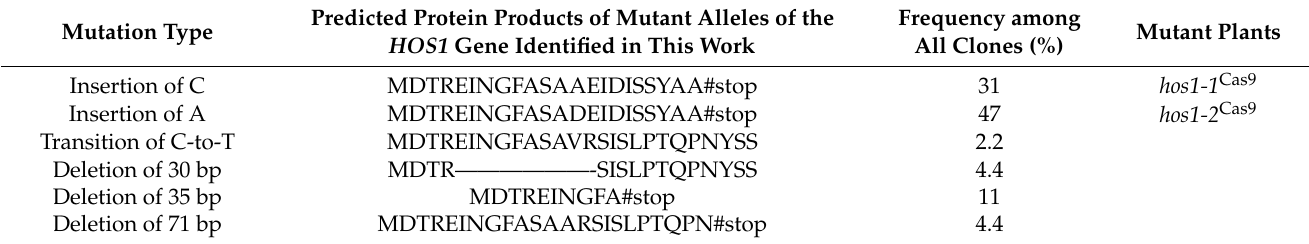
Table 1. Types and frequencies of identified Cas9-mediated mutations in HOS1